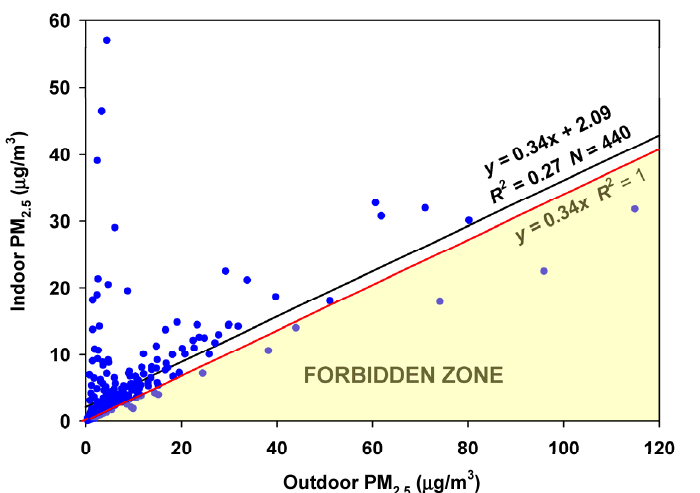
Figure 6. RCS regression of indoor on outdoor air for the June through November data in Oakmont.